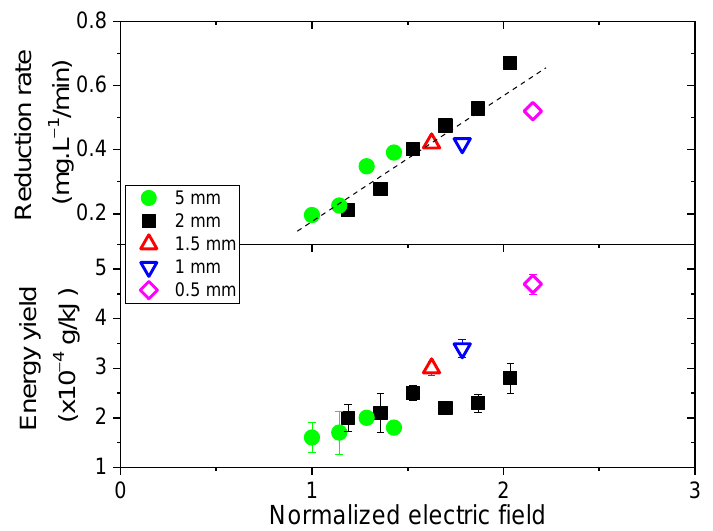
Figure 8. Influence of the electric field on Cr(VI) reduction (reduction rate and energy yield after 2 h of process) according to the normalized maximum electric field for pin-to-pin discharges in Cr(VI) solution (47 mg/L, σ = 4 mS/cm, pH = 2.3), V = 100 mL, ∆ t = 500 µ s, electrode length = 0 ± 10 µ m, f = 50 Hz.